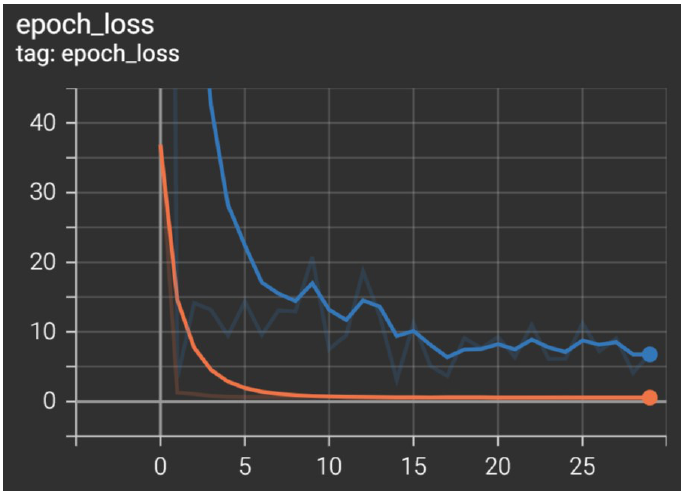
Figure 20. Graph of the loss trend with respect to epochs: the train loss is reported in red, while the validation is in blue. A smooth factor of 0.6 has been